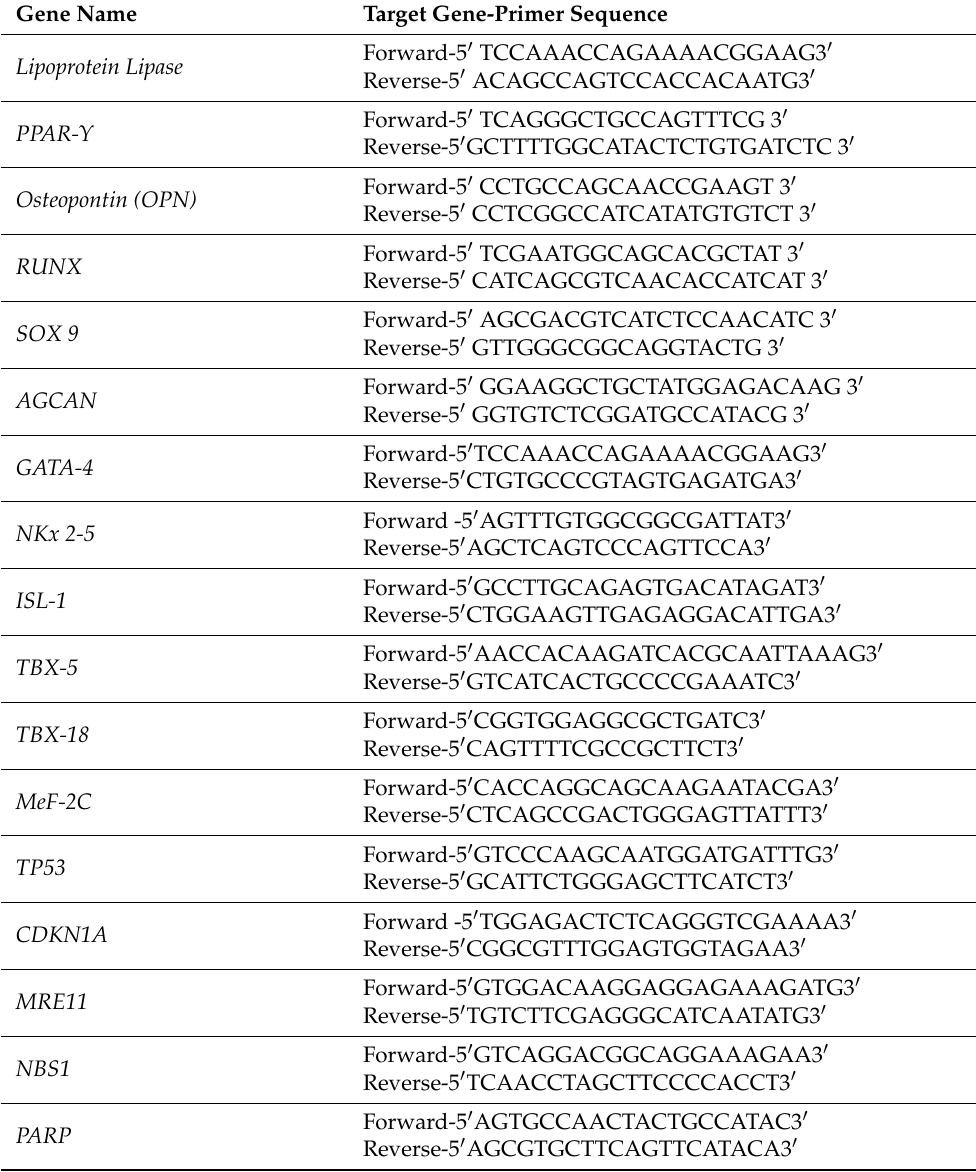
Table 2. Primer sequences of the target